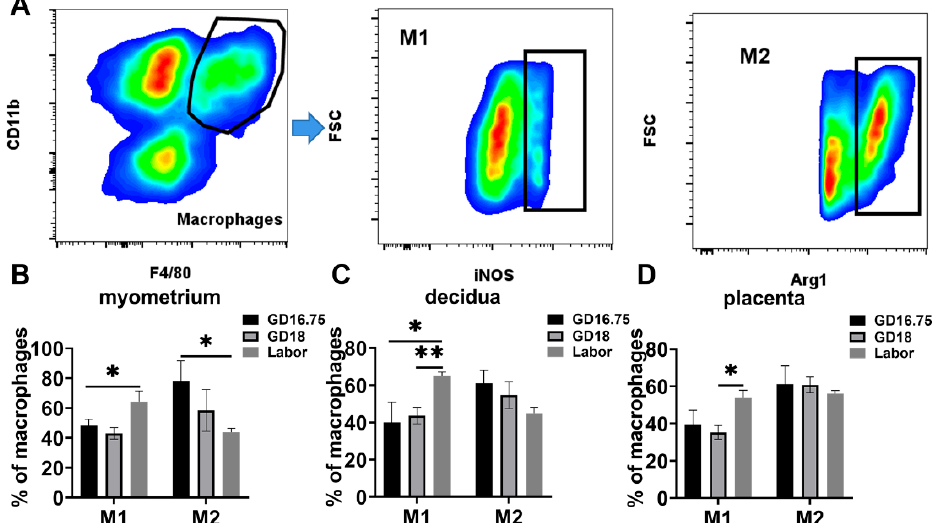
Figure 3. Characteristics in M1 and M2 populations in gestational tissues at late gestation and labor. The pregnant mice were sacrificed at GD16.75, GD18, and labor. ( A ) Gating strategy was used to identify M1 (Dye − CD45 + CD11b + F4/80 + iNOS + ) and M2 (Dye − CD45 + CD11b + F4/80 + Arg1 + ). ( B ) Populations of M1 and M2 in myometrium; ( C ) populations of M1 and M2 in decidua; ( D ) populations of M1 and M2 in placenta. Data are expressed as mean ± SEM. n = 5 in each group. * p < 0.05, ** p < 0.01.